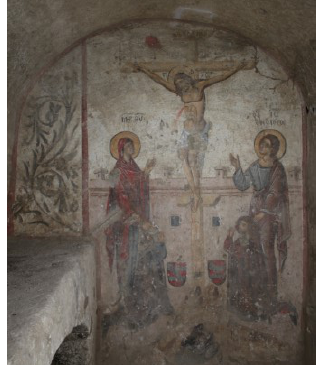
Figure 3. The mural of the Crucifixion in the